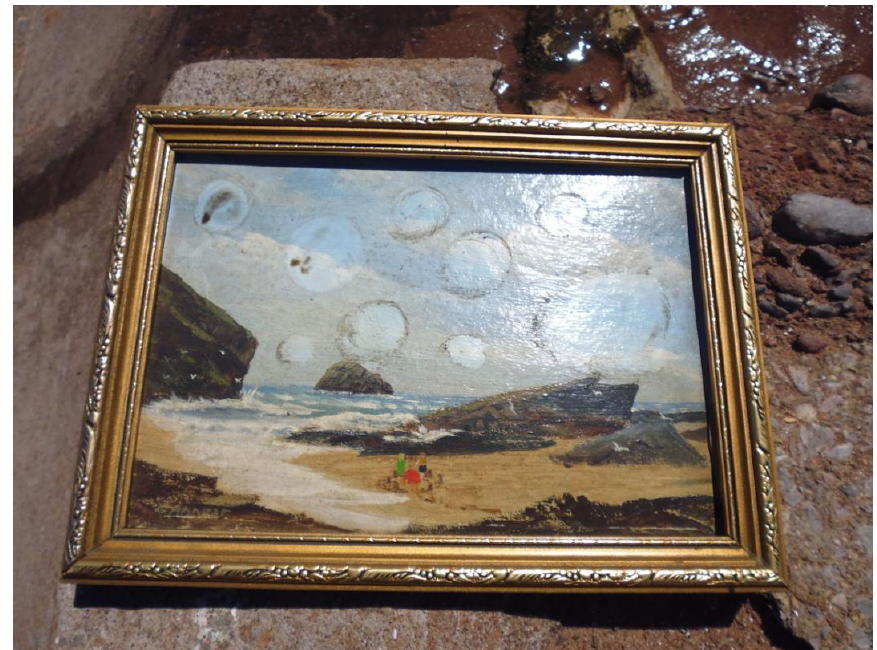
Figure 13. Painting wiped in circles.